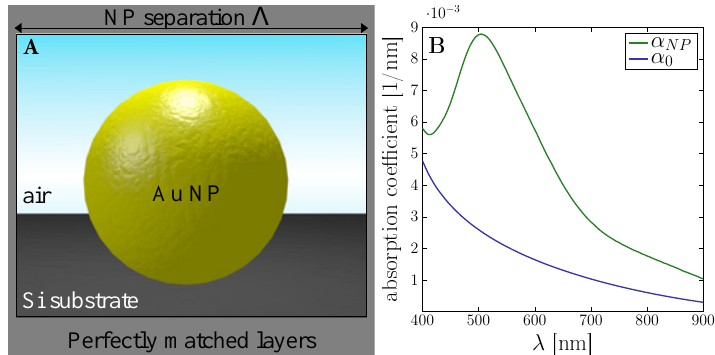
Figure 1. Illustration of the photo-effect. ( A ) The computational square unit cell of width Λ consists of a gold nanoparticle in its center on a Si substrate. ( B ) The probability of photon absorption for a single gold nanoparticle of a = 50 nm in the Si substrate increases significantly in the optically coupled system compared to the bare